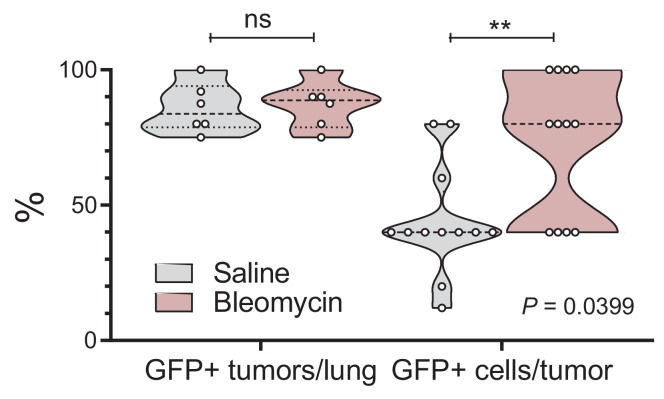
Alveolar type II cell ablation using bleomycin pre-treatment increases airway-labeled cells in urethane-induced lung tumors: data summary.Violin plot of GFP-labeled tumors/mouse (n = 6 mice/group) and GFP-labeled cells/tumor (n = 12 tumors/group; n = 2 tumors/mouse were examined) from experiment described in Figure 4—figure supplement 1. Note the enrichment of lung adenocarcinomas in GFP-labeled cells in response to bleomycin, which depletes resident alveolar type II cells. P, overall probability, two-way ANOVA. **: p<0.01 for comparison with saline, Bonferroni post-test.10.7554/eLife.45571.051Figure 4—figure supplement 2—source data 1.Quantification of GFP+ tumors/lung and GFP+ cells/tumor in GFP;CCSP.CRE mice after bleomycin and urethane treatment.